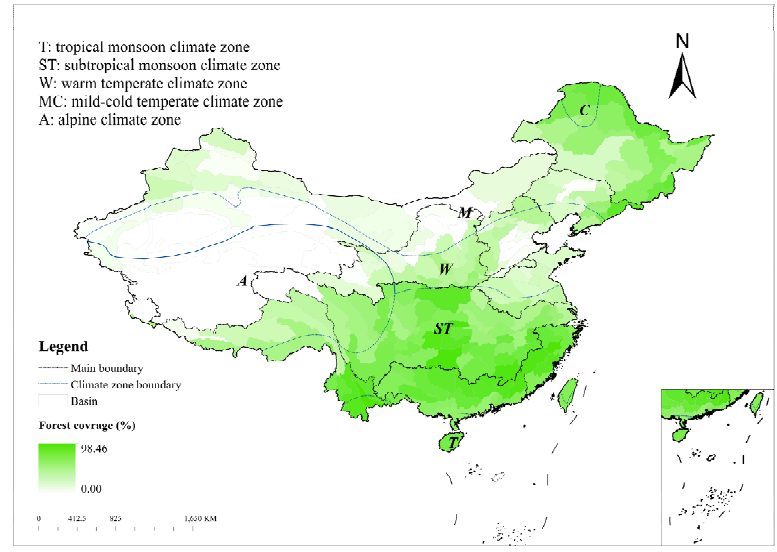
Figure 1. The distribution of 214 third-order watersheds across six climate zones in China.